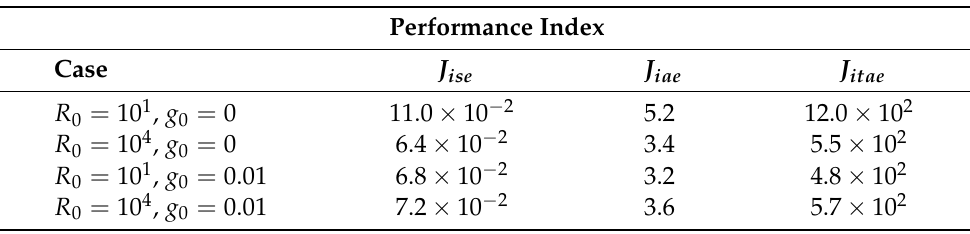
Table 3. Performance indexes for the experiment with different levels of robust adaptation ( g 0 = 0 no dead zone; a large R 0 approximates an unconstrained covariance matrix P